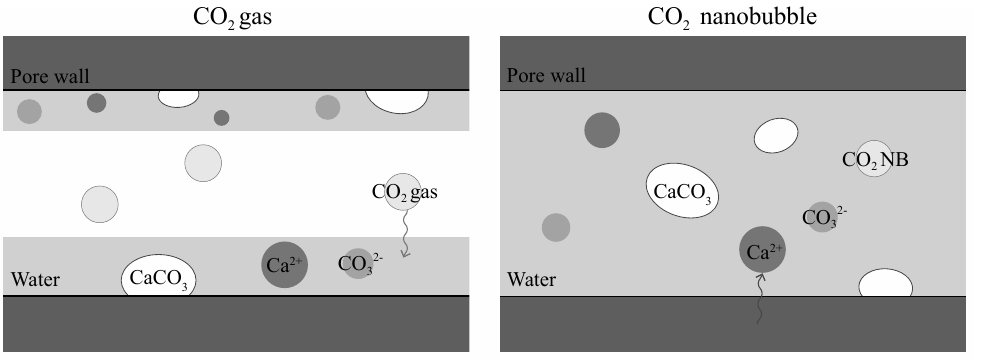
Figure 6. Comparison of porosity reduction ratios calculated two ways.